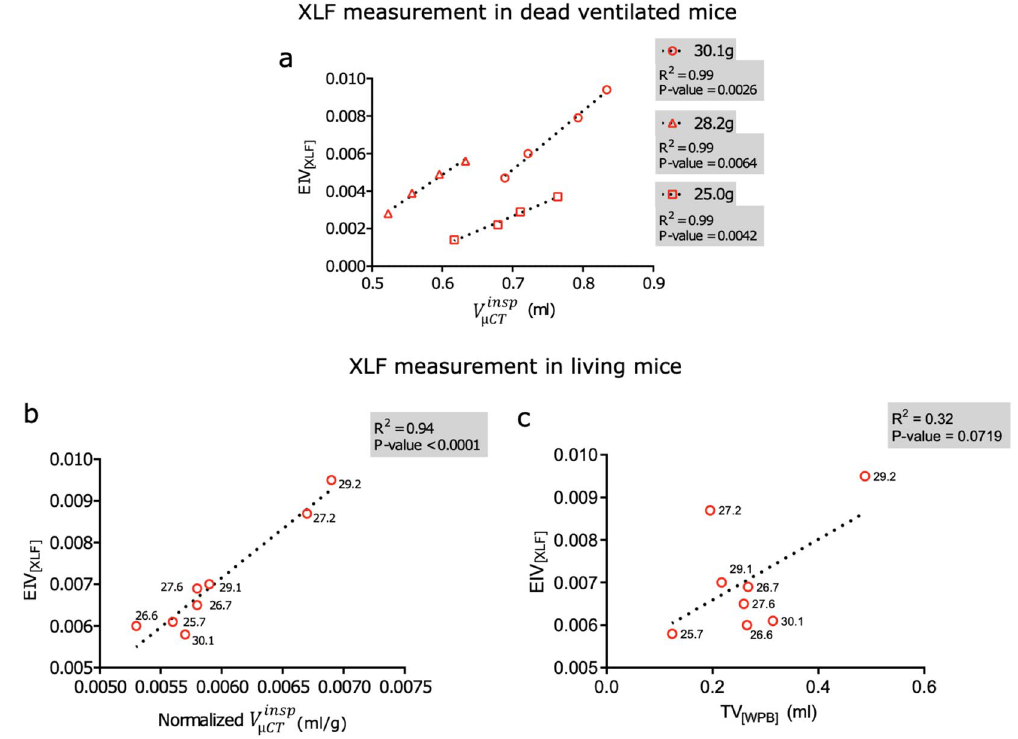
Figure 6. Correlation of XLF measurements with micro-CT and WBP. ( a ) Graph showing a strong positive insp correlation between EIV [XLF] with V [ µ CT ] performed on dead mechanically ventilated mice (n = 3). ( b ) Graphs insp 2 = 0.94) and ( c ) a weak correlation of showing a strong positive correlation between EIV [XLF] and V [ µ CT ] (R TV [WBP] with EIV [XLF] (R 2 = 0.32). Data for both b and c is shown for living mice (n = 8). The respective p values and coefficients of determination (R 2 ) from linear regression analysis are shown on the graph. ( b , c ) All points are labelled with the respective weights of the